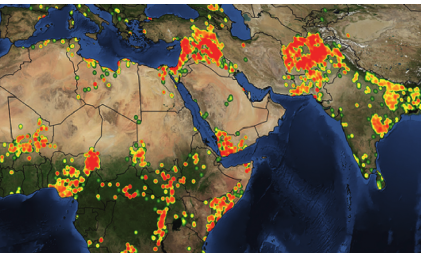
Figure 1: GTD world map highlighting the intensity of terrorism in the year 2017 (focused on South Asia, the Middle East, and